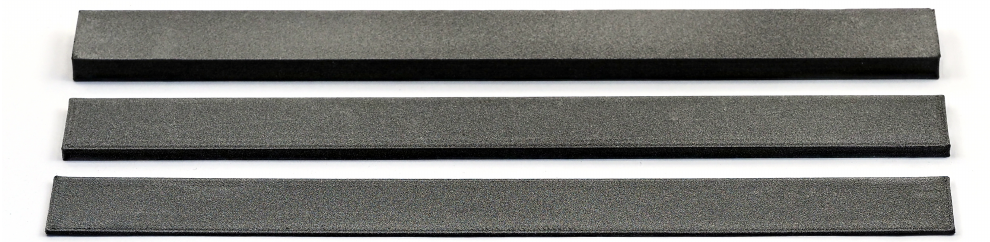
Figure 3. Overview of investigated specimen of three different thicknesses (6mm, 3mm, 1mm).